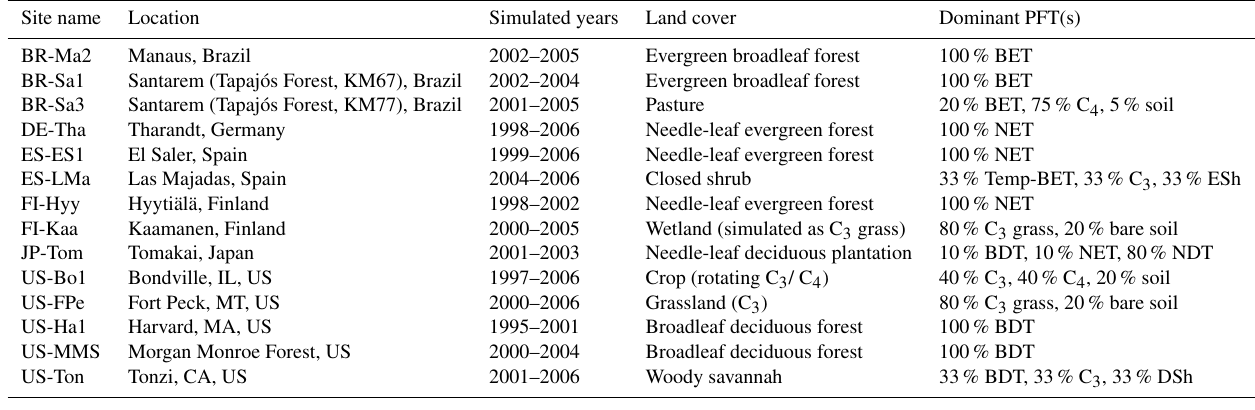
Table 4. Sites used in the site simulations. Land cover is according to site PI.